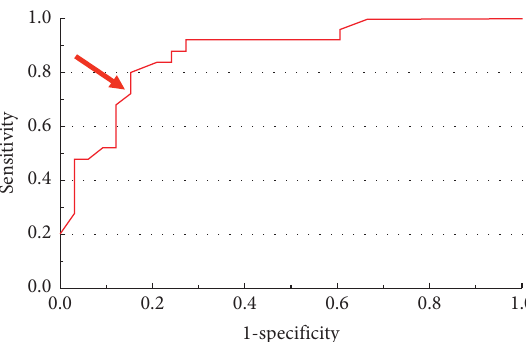
Figure 9: ROC (receiver operating characteristic) curve of ADC value for the risk of being malignant. Youden index reaches its maximum value (YI � 0.655) for a threshold lesser than or equal to 0.86 × 10 − 3mm 2 /s (arrow) (sensitivity � 73%; specificity �